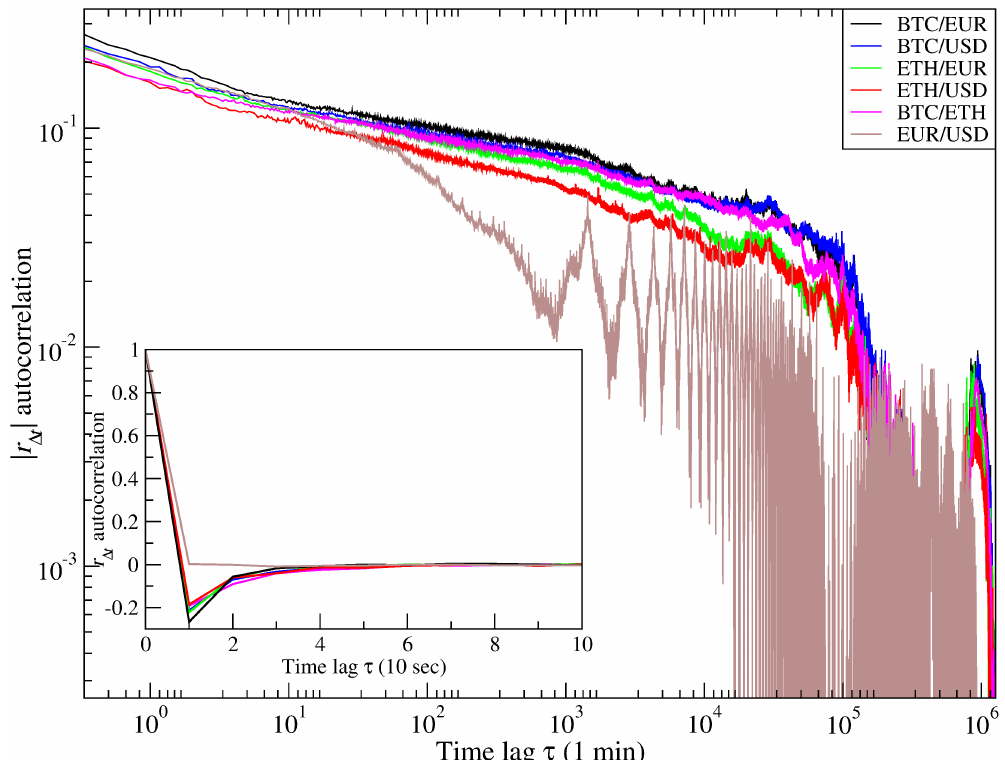
Figure 3. (Color online) Volatility autocorrelation functions C ( τ ) for to the BTC/EUR, BTC/USD, ETH/EUR, ETH/USD, BTC/ETH and EUR/USD exchange rates over the period between 1 July 2016 and 31 December 2018. The daily trend was removed according to an established procedure